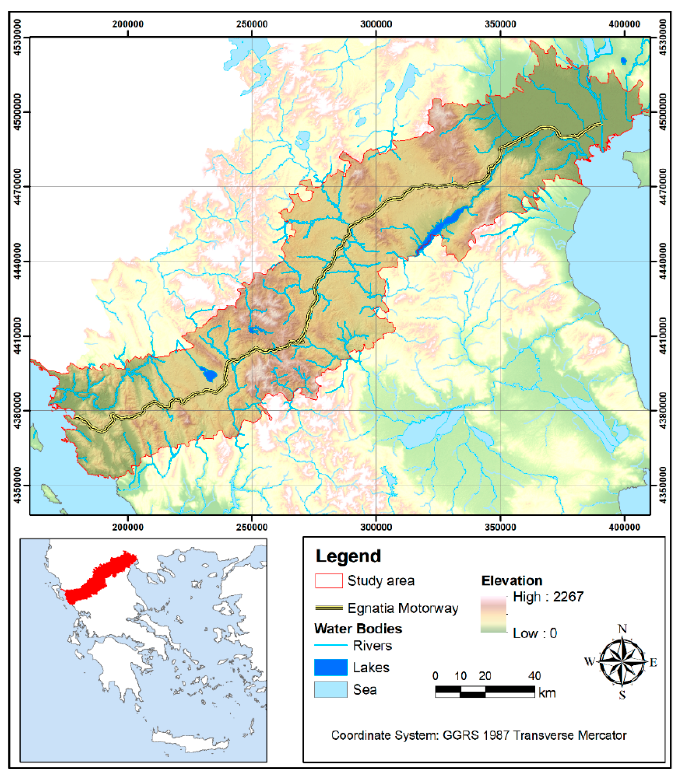
Figure 1. Geomorphological map of the study area, displaying the main water